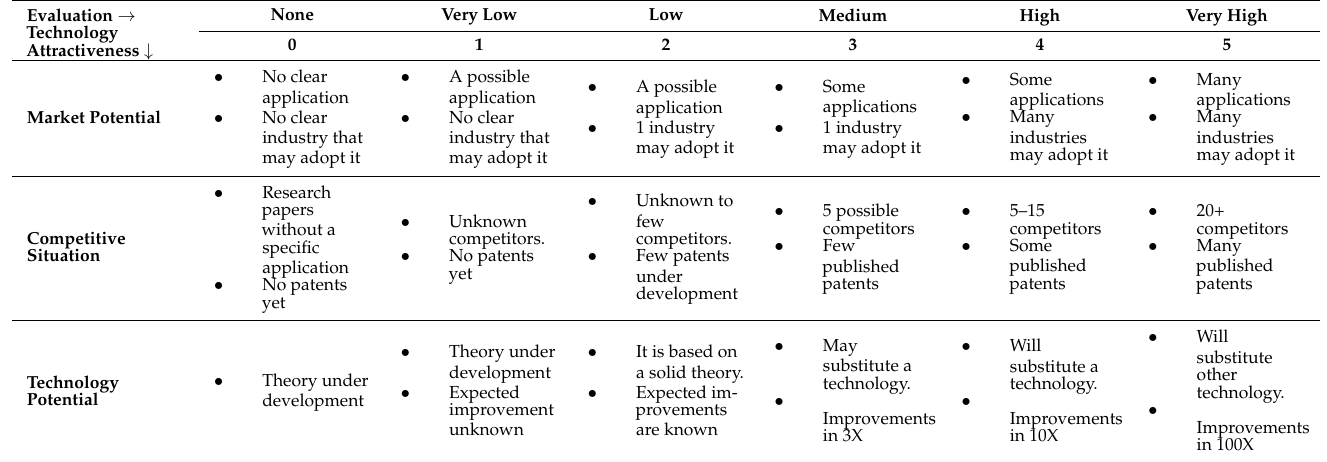
Table 3. Technology attractiveness evaluation.